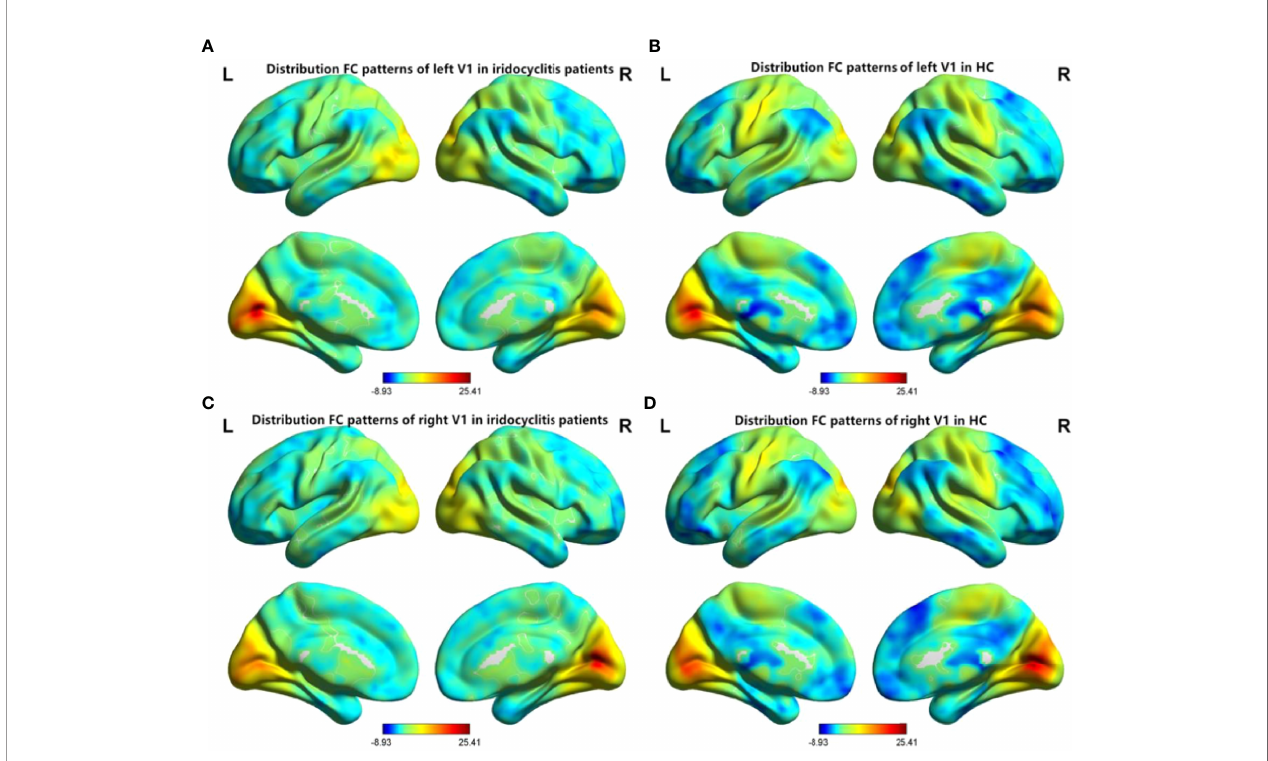
FIGURE 2 | Spatial distributions of FC patterns of the bilateral V1 of the patients with iridocyclitis and HCs. (A) Distribution average zFC values of left V1 in patients with iridocyclitis; (B) Distribution average zFC values of left V1 in HCs; (C) Distribution average zFC values of right V1 in patients with iridocyclitis; (D) Distribution average zFC values of right V1 in HCs. zFC, z-value functional connectivity; HC, healthy